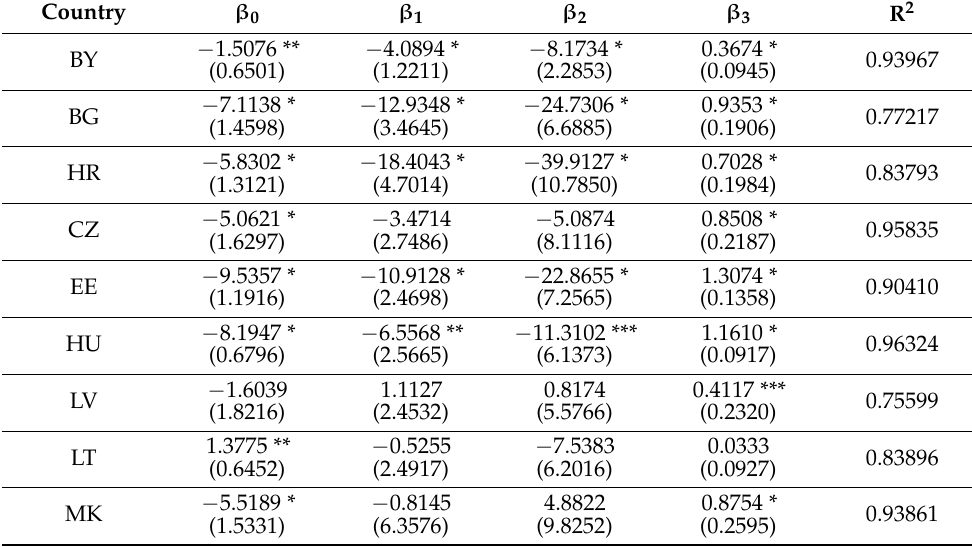
Table 7. Estimation of model parameters for independent variables HDI index and EC.